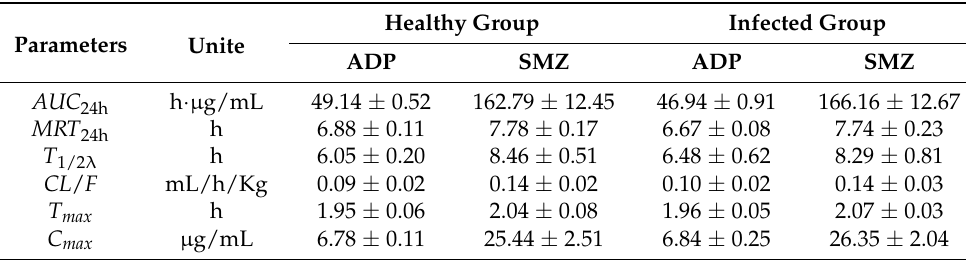
Table 5. The PK parameters of ADP and SMZ in PELF after intramuscular injection of ADP/SMZ